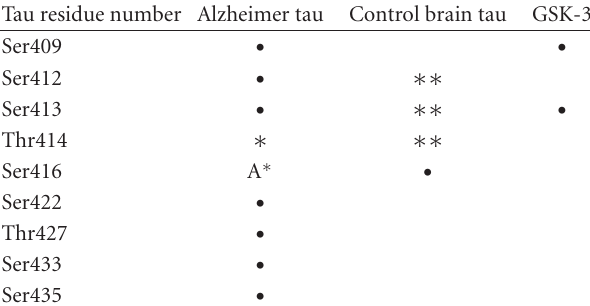
Numbering of residues refers to 2N4R human tau, the largest isoform present in the human CNS. • indicates tau phosphorylation sites identified by direct means. A indicates tau phosphorylation sites identified using phospho-specific tau antibodies. ∗ indicates that one of the two closely spaced phosphorylation sites indicated (Thr414, Ser416) is phosphorylated in tau from AD brain. ∗∗ indicates that two of the three closely spaced phosphorylation